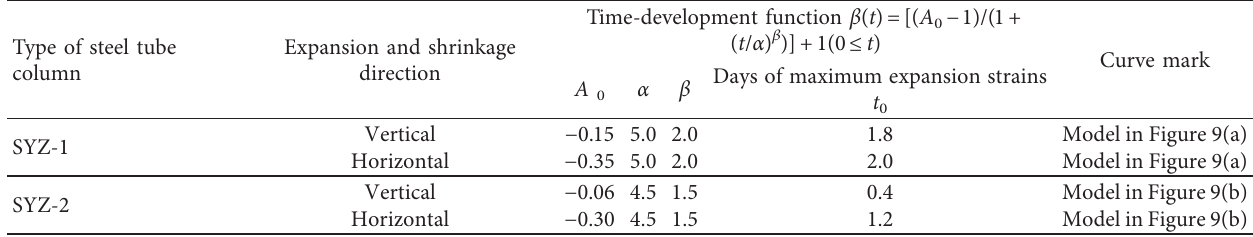
Table 6: The parameter values of time-development function for the early-age shrinkage and expansion.